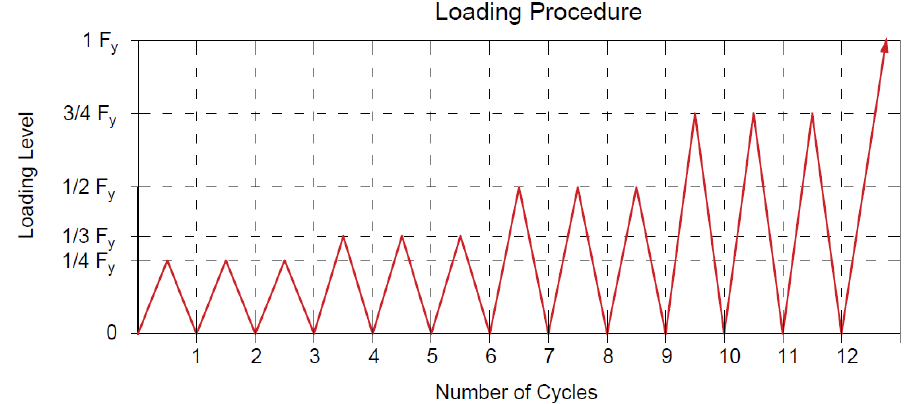
Figure 3. Loading history for the C Group